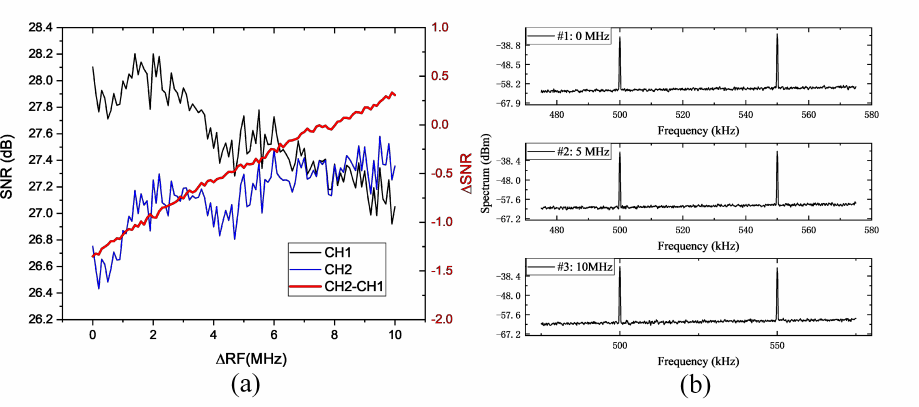
Figure 4. Interchannel interference performance of FM communication. ( a ) SNR of two channels changes with ∆ RF . ( b ) Received signals when ∆ RF is 0, 5 and 10 MHz